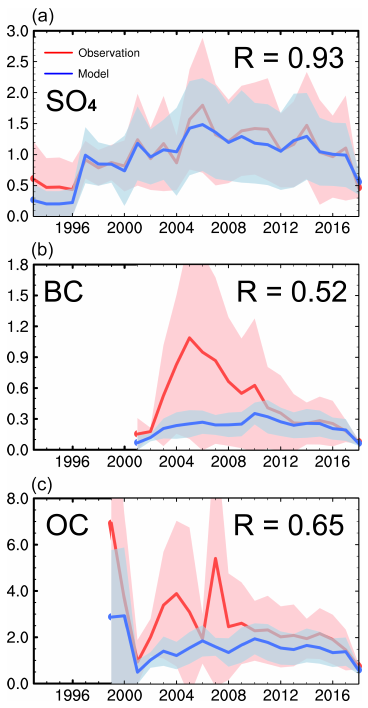
Figure 3. Time series (1993–2018) of spatial and annual mean near- surface (a) sulfate, (b) BC, and (c) OC concentrations (in micro- grams per cubic meter) in Europe from model simulation (blue lines) and observations (red lines). Model results are plotted only when EMEP observational data are available. Shaded areas repre- sent 1 σ spatial standard deviation of annual mean concentrations for each year. Temporal correlation coefficients ( R ) between ob- served and simulated spatially averaged concentrations are noted in Figure 2. Spatial distribution of simulated (contour) and observed the top-right corner of each (color-filled circles) annual mean near-surface (a) sulfate, (b) BC, and (c) OC – derived as (POA + SOA)/1.4 in model – concen- trations (in micrograms per cubic meter) for 2010–2014. Obser- vations are from EMEP (European Monitoring and Evaluation Programme) networks. Normalized mean bias, NMB = 100% × (cid:80) ( Model (cid:80) Observation − Observation site site )/ site , and correla- tion coefficient ( R ) between observed and simulated concentrations are noted at the top of each panel.